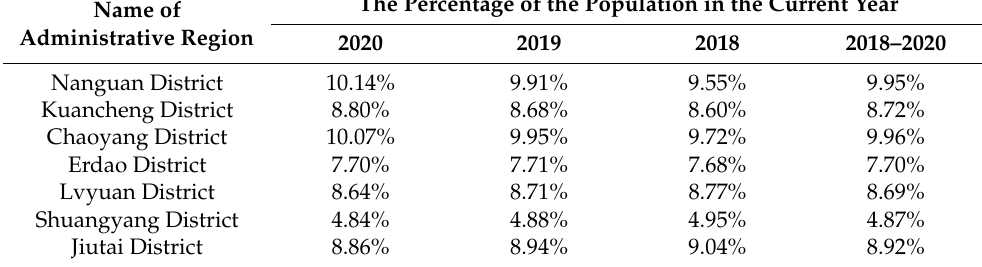
Table A2. The proportion of the population of each district in the total population of Changchun in M region.